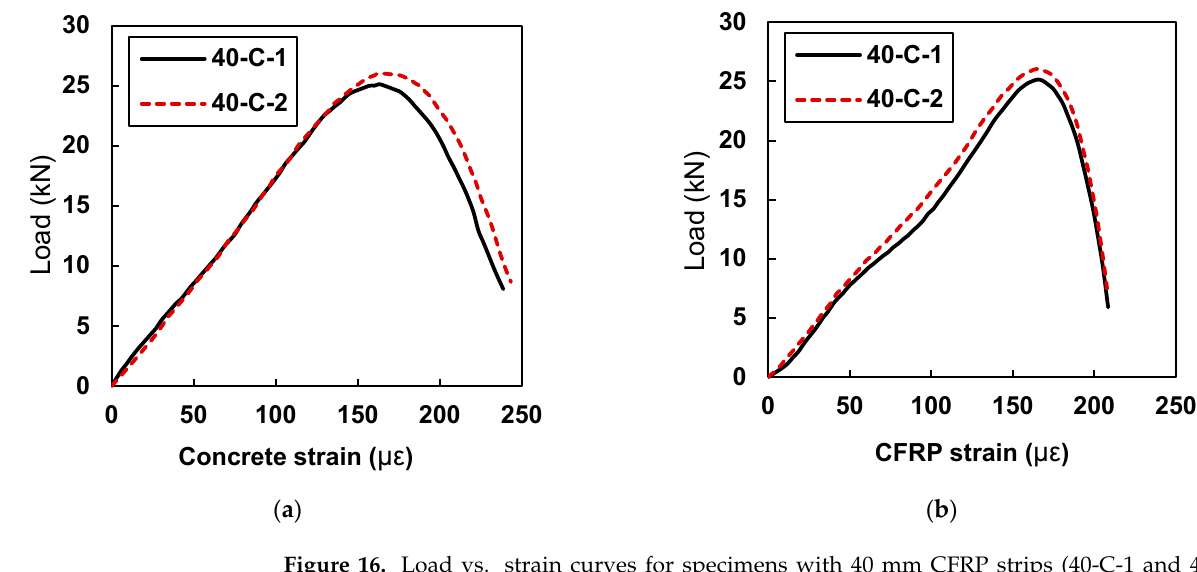
( b ) Figure 15. Load vs. strain curves for specimens with 30 mm CFRP strips (30-C-1 and 30-C-2): ( a ) strain in concrete and ( b ) concrete strain in CFRP.